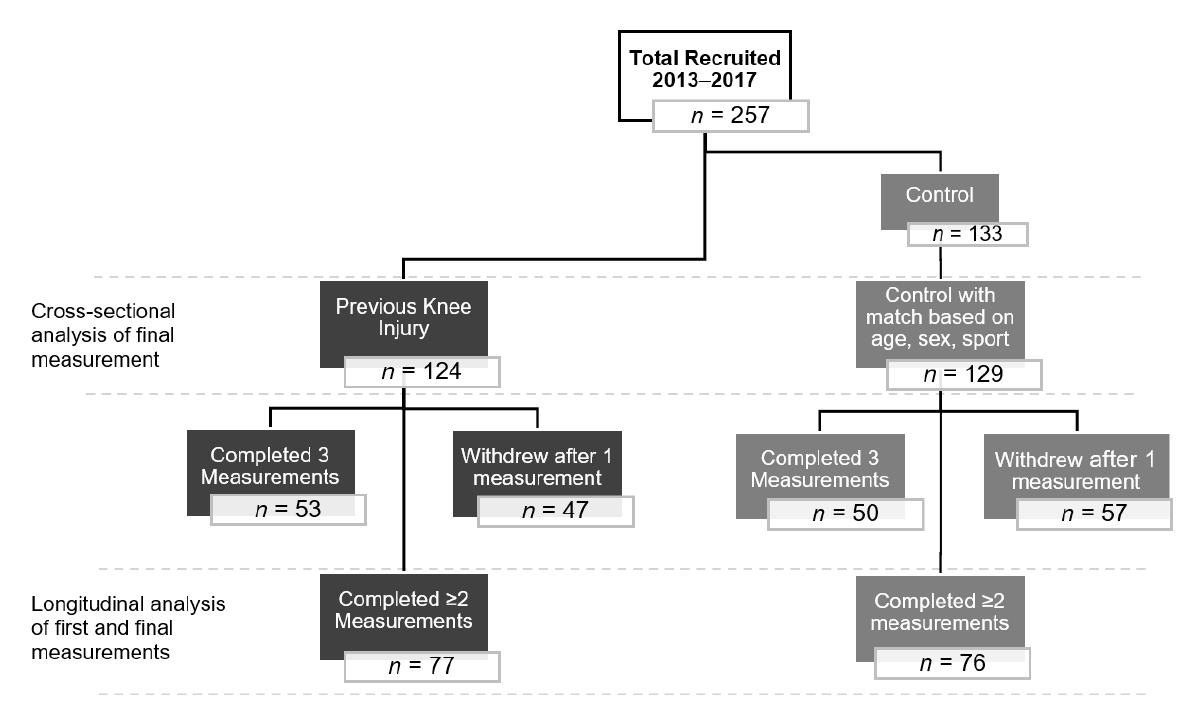
Figure 1. Flowchart of participant recruitment and follow-up for the Alberta Youth Prevention of Early Osteoarthritis (PrE-OA) cohort.